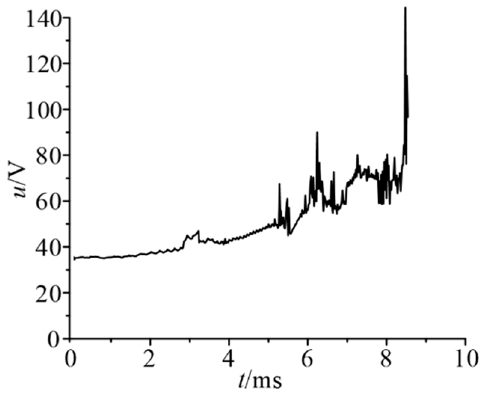
Figure 7. Arc voltage curve.